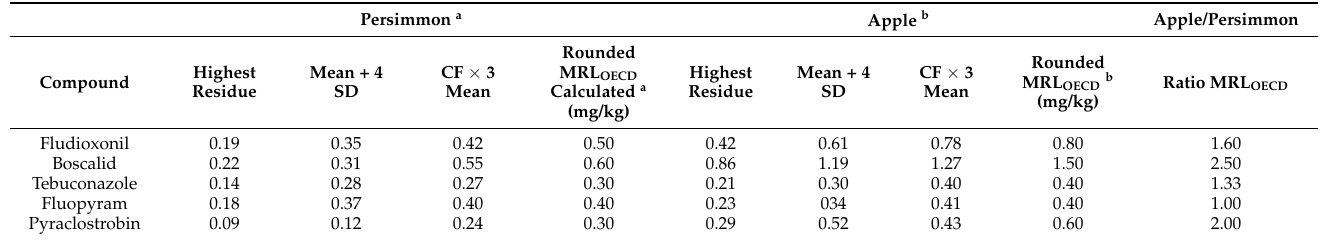
Table 6. MRL calculations of persimmons and apples and ratio for both